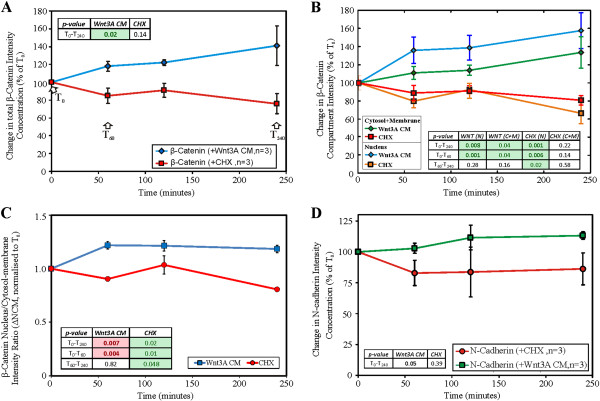
Quantification of β-catenin and N-cadherin in stimulated/inhibited HEK293T cells. HEK293T cells were stimulated with Wnt3A CM or inhibited by CHX for 0, 1, 2, or 4 hours. (A) Relative change in β-catenin concentration intensity (in terms of % of T0); (B) Relative change in β-catenin compartment concentration intensity (in terms of % of T0); (C) β-catenin Nucleus/Cytosol-membrane intensity ratio (normalized to T0); (D) Relative change in N-cadherin concentration intensity (in terms of % of T0); Error Bars: (A and D) Standard deviations, (B and C) Standard Error of the Mean. n = 3; each data point has ≥ 3 image sets. A single factor analysis of variance (ANOVA) test was applied to test for differences between data points for each perturbation, specifically between T0-T240, T0-T60 and T60-T240.